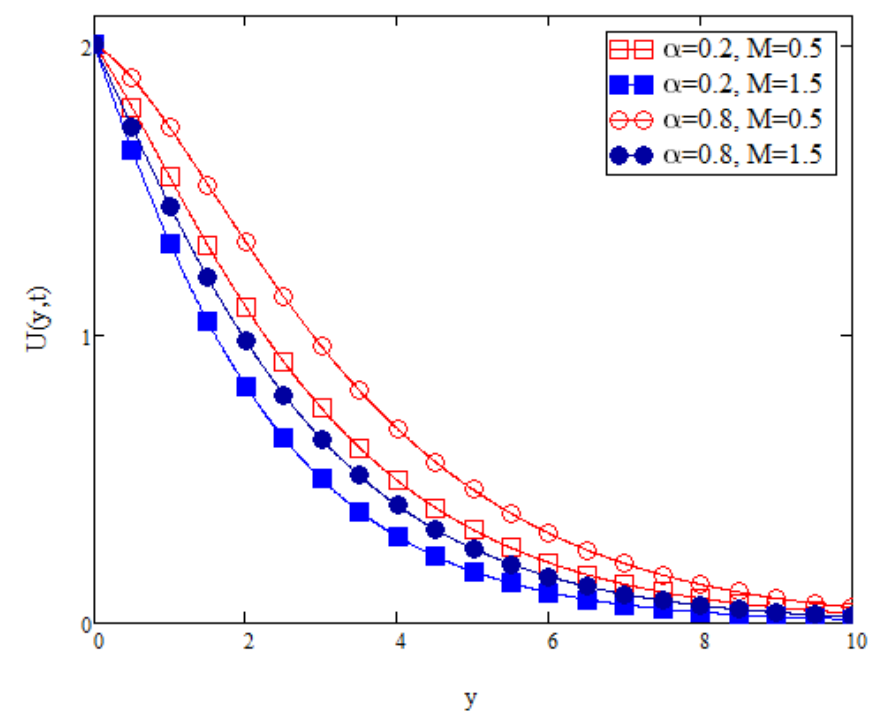
Figure 14. Variation in velocity profile due to variations in M and α .